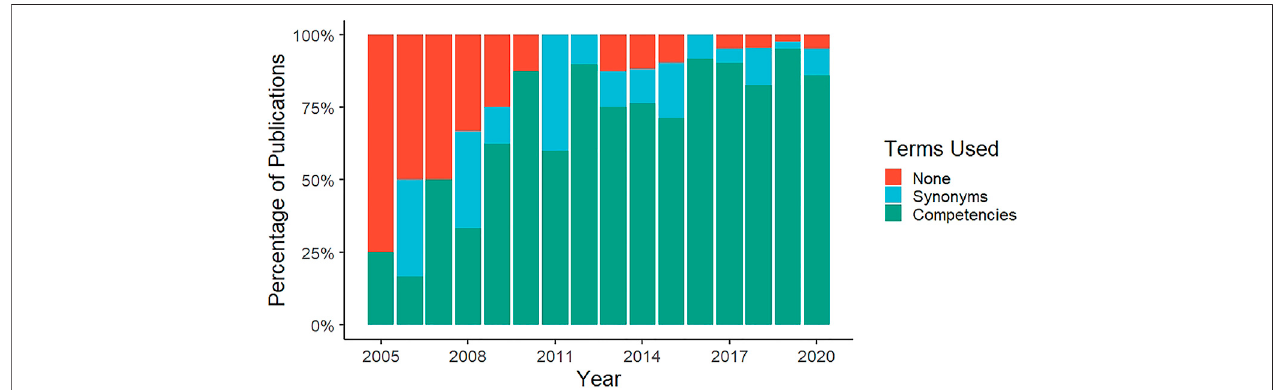
FIGURE 3 | Percentage of publications mentioning competencies versus all other synonyms ( “ literacy ” etc.) in title, keywords, or abstract by year (2005 – 2020) (publications prior to 2005 ( n (cid:1) 10) were excluded for better